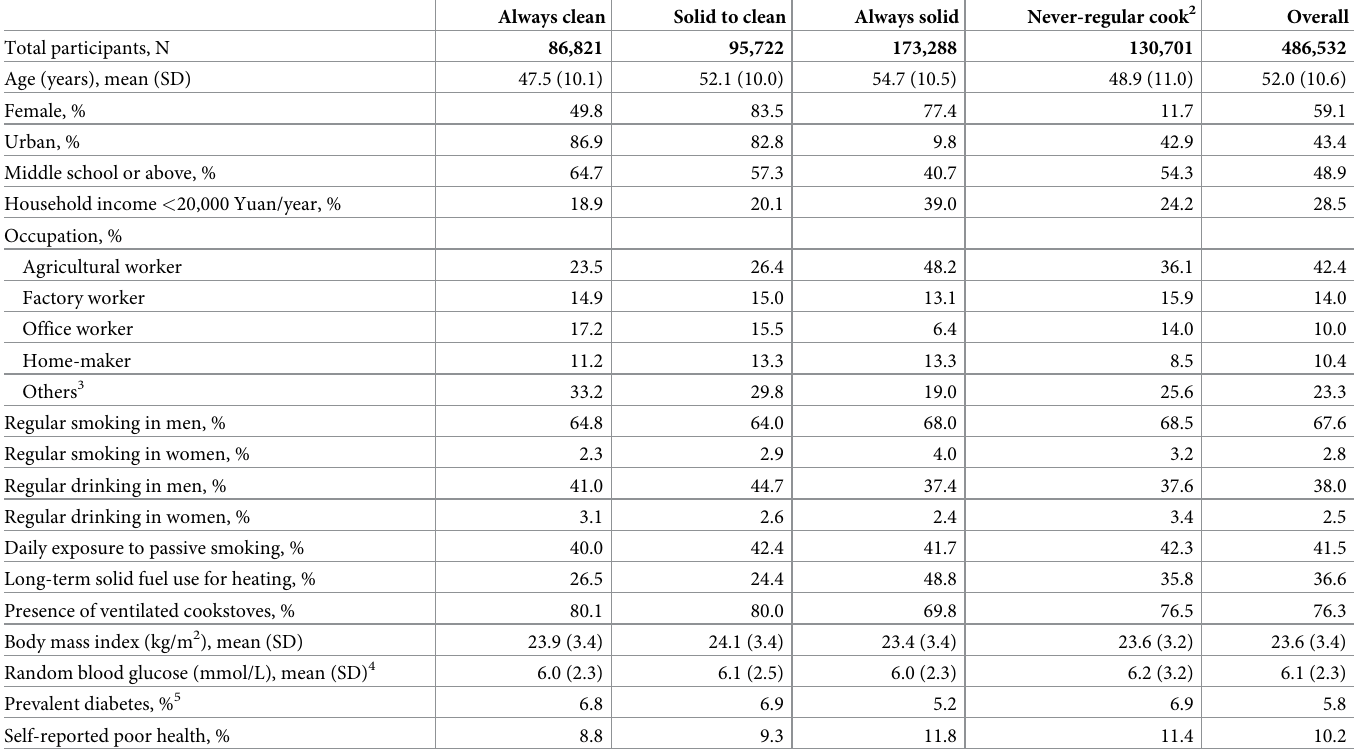
Table 1. Baseline participant characteristics by long-term solid fuel use for cooking 1